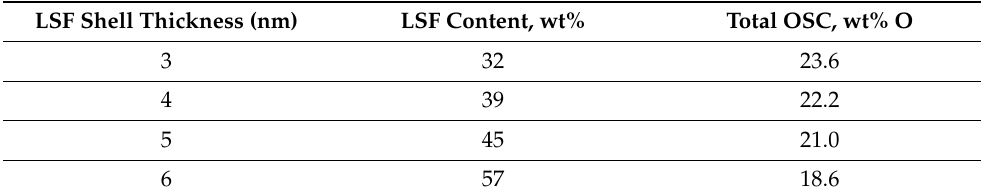
Table 2. Estimation of OSC and LSF-perovskite content in